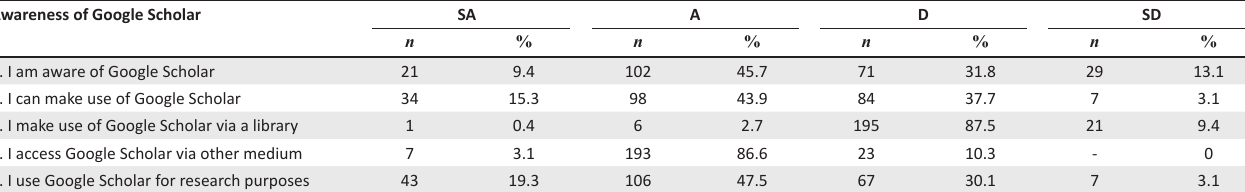
TABLE 2: The level of awareness of Google Scholar. Awareness of Google Scholar